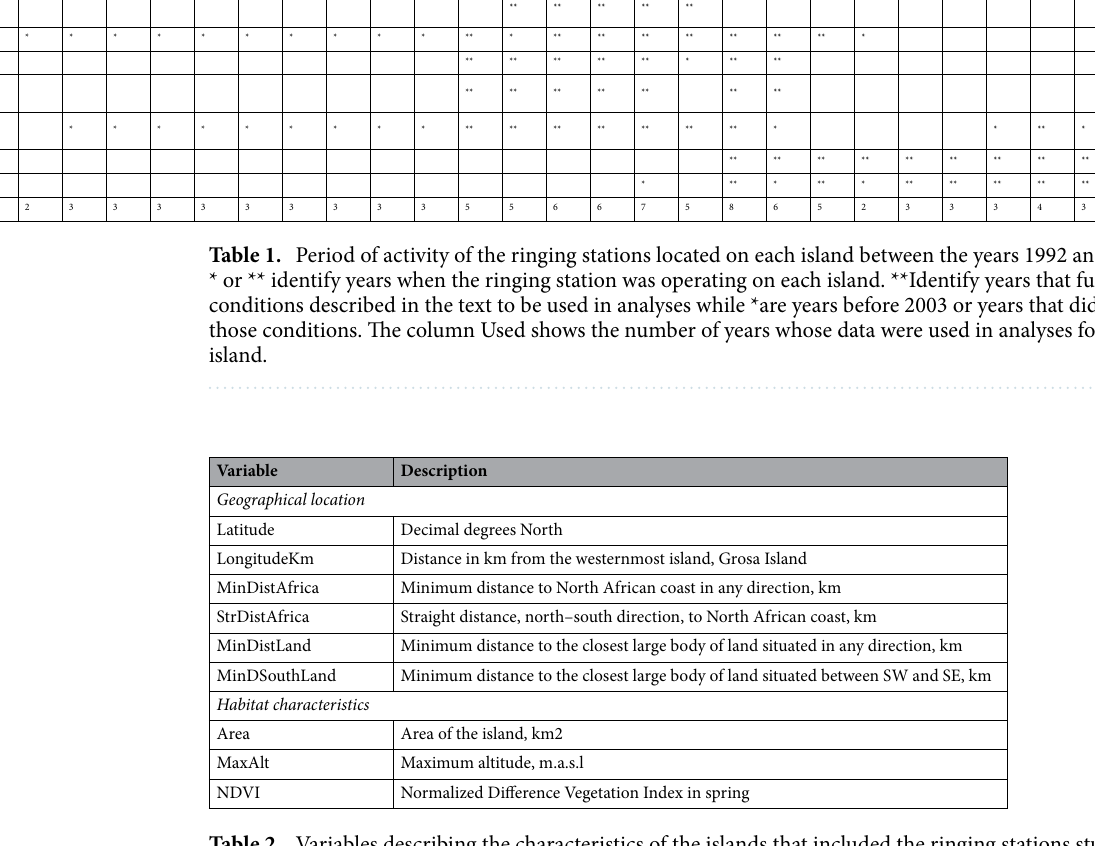
Table 2. Variables describing the characteristics of the islands that included the ringing stations studied.